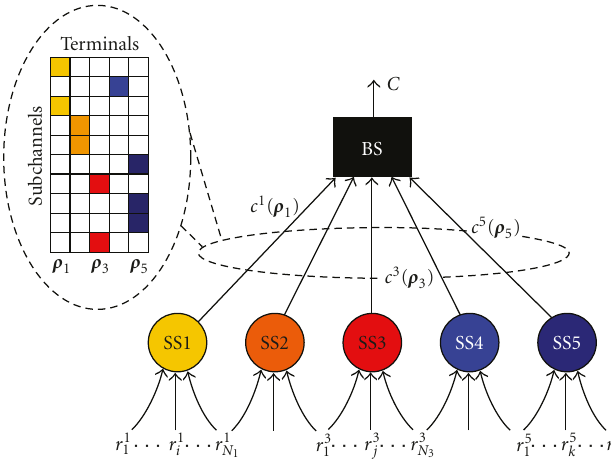
Figure 1: Reference